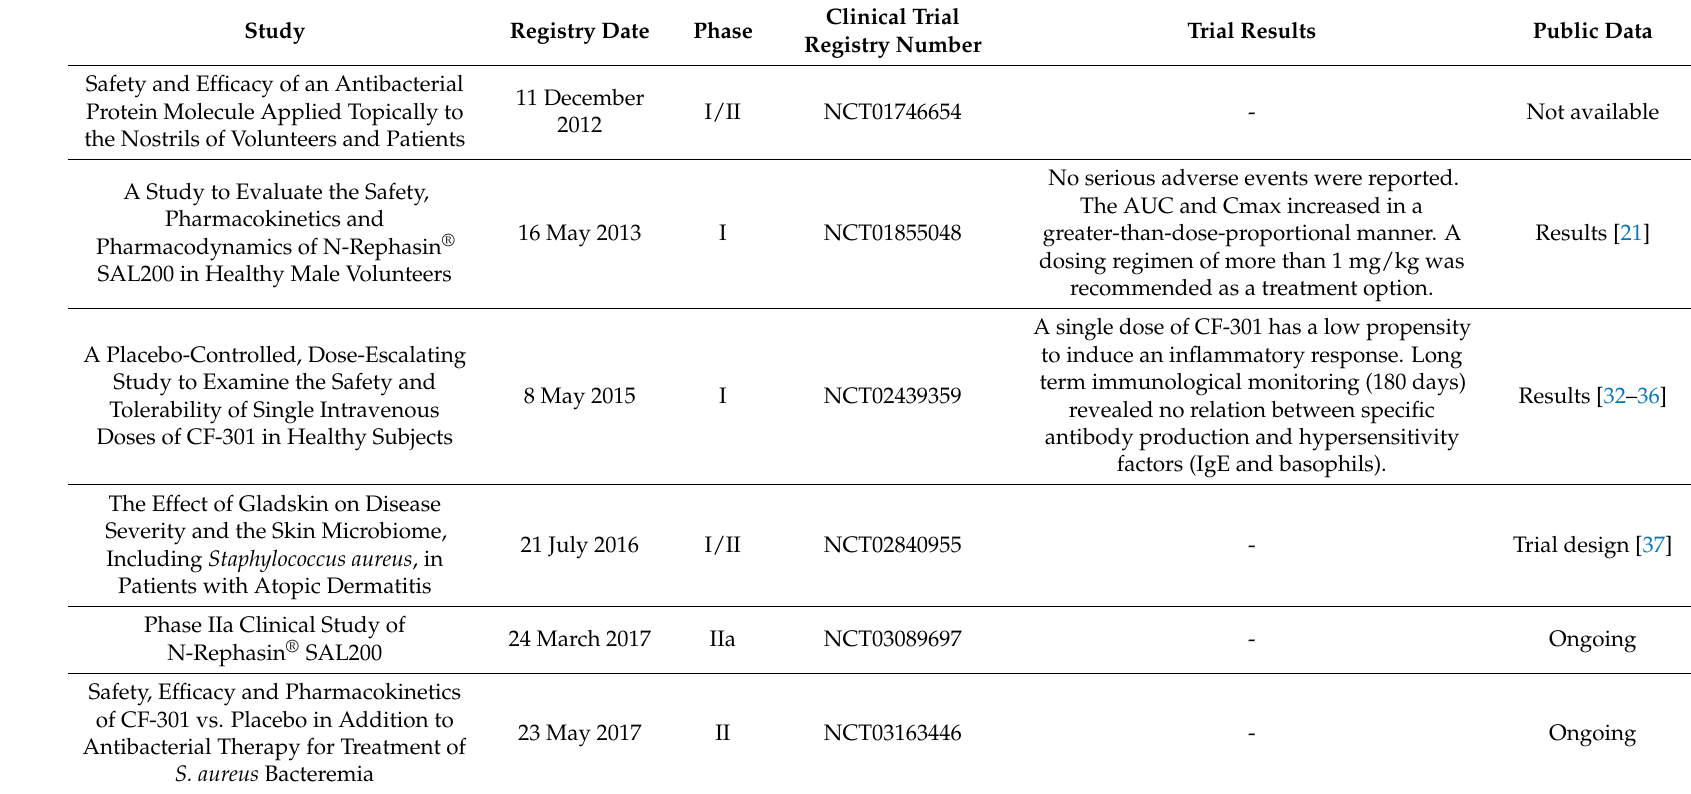
Table 2. Clinical trials of phage lytic enzymes ranked according to registry